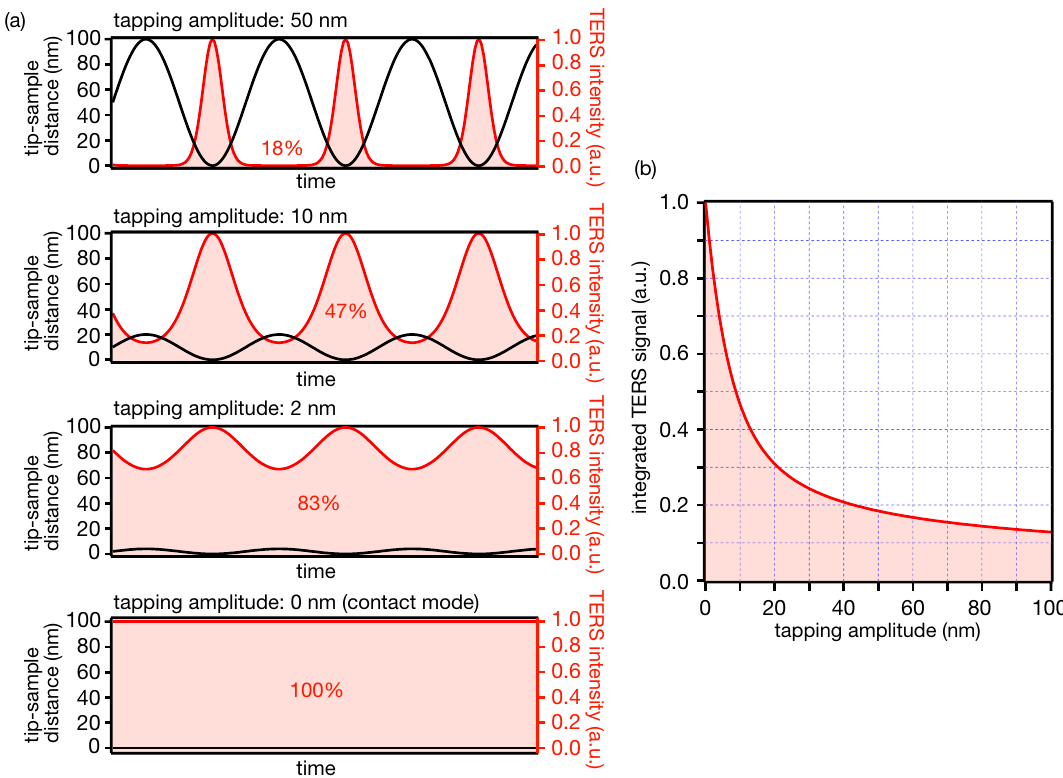
Figure 2. ( a ) Time variation of the tip-sample distance and TERS intensity at different tapping amplitudes. ( b ) Relationship between integrated TERS signal and the tapping amplitude. The TERS signal is normalized by the signal obtained at the 0 nm amplitude, that is, the contact